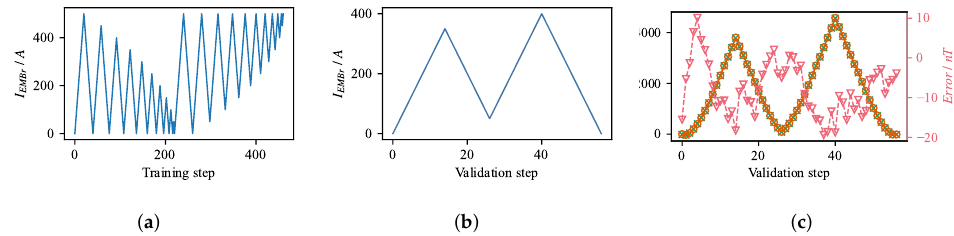
Figure 3. Compensation error of the Krasnosel’skii–Pokrovskii (KP) hysteresis model. ( a ) Current profile used for identification of the model weights; every measurement step represents a period of fifteen seconds, during which the mean value of the flow-induced magnetic was recorded for each sensor as an input to the hysteresis model. Current is changed in steps of ∆ I EMBr = 25 A. ( b ). Current profile used to validate the accuracy of the model. For each step the corresponding value of the flow induced magnetic field is recorded and compared to the output of the model in case of the use of same current profile as an input to the model. ( c ) Absolute error of the model shown for the middle gradiometric coil on the right side of the mould (Sensor